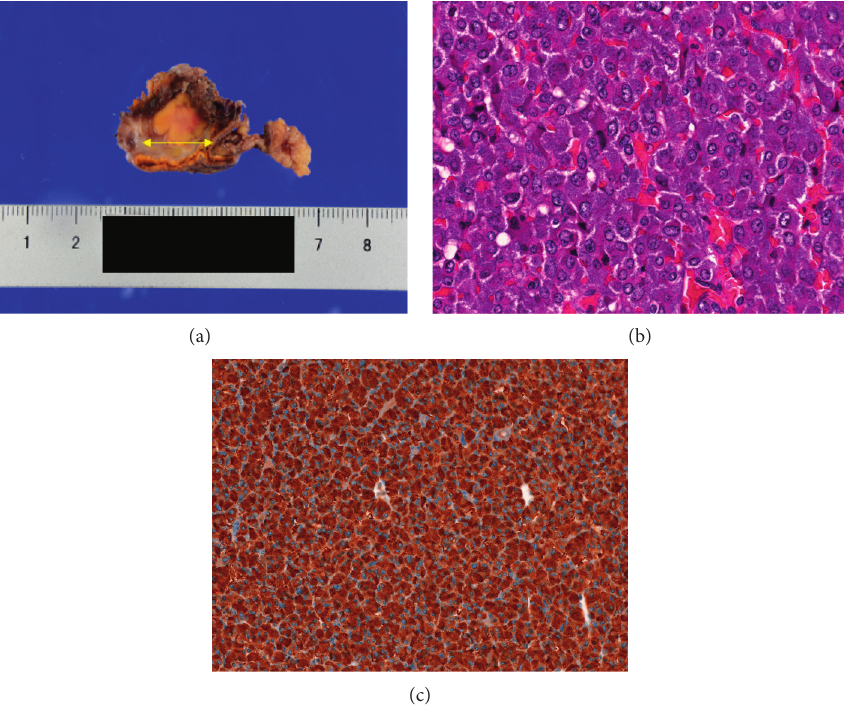
Figure 4: Histopathological findings of the resected adrenal gland. (a) The cut surface of the tumor. The left adrenal tumor (a double-headed yellow arrow) measured 13mm × 12mm × 11mm. (b) The section showed the large and irregular cell nest arrangement of tumor cells (hematoxylin and eosin × 400). (c) The brown staining showed the expression of chromogranin A in the tumor ×